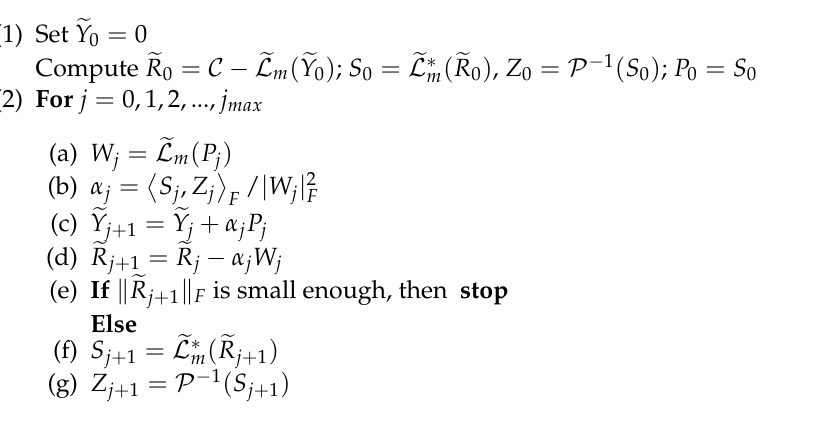
Algorithm 3. The Preconditioned Global Conjugate Gradient (PGCG)